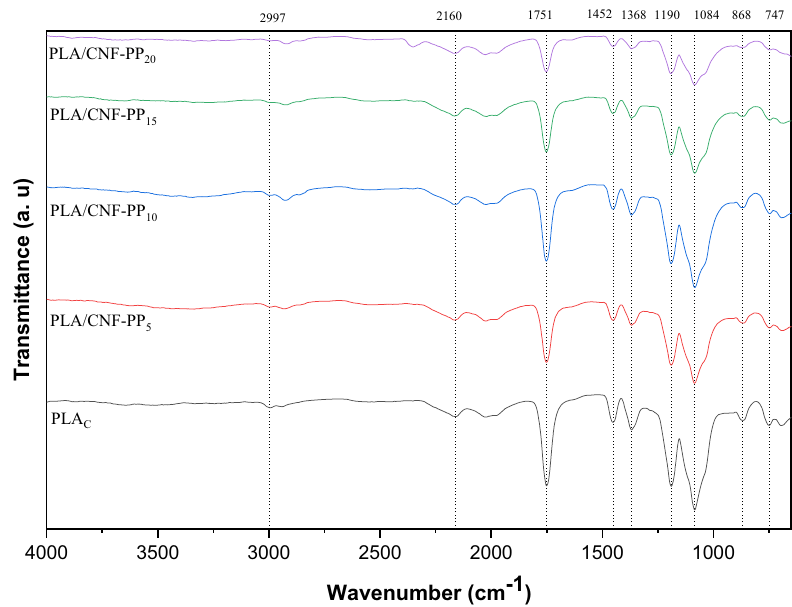
Figure 4: FTIR analysis of PLA sca ff olds with di ff erent CNF